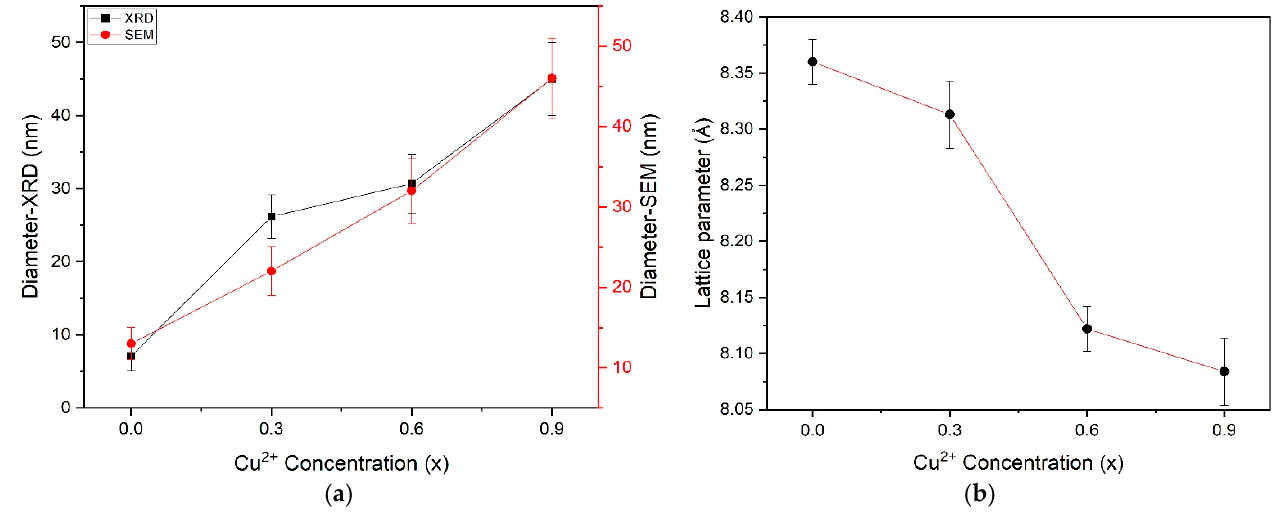
Figure 6. Graphical representation of lattice parameter ( a ) and diameter calculated by Debye–Scherer formula and SEM ( b ) of plant-extracted cobalt ferrite nanoparticles Co 1 − x Cu x Fe 2 O 4 . The values of lattice parameter, diameter and volume of plant-extracted pure cobalt ferrite nanoparticles and copper-substituted cobalt ferrite nanoparticles are tabulated in Table 2. The value of the lattice parameter for pure CoFe 2 O 4 is a = 8.360 Å and is decreased